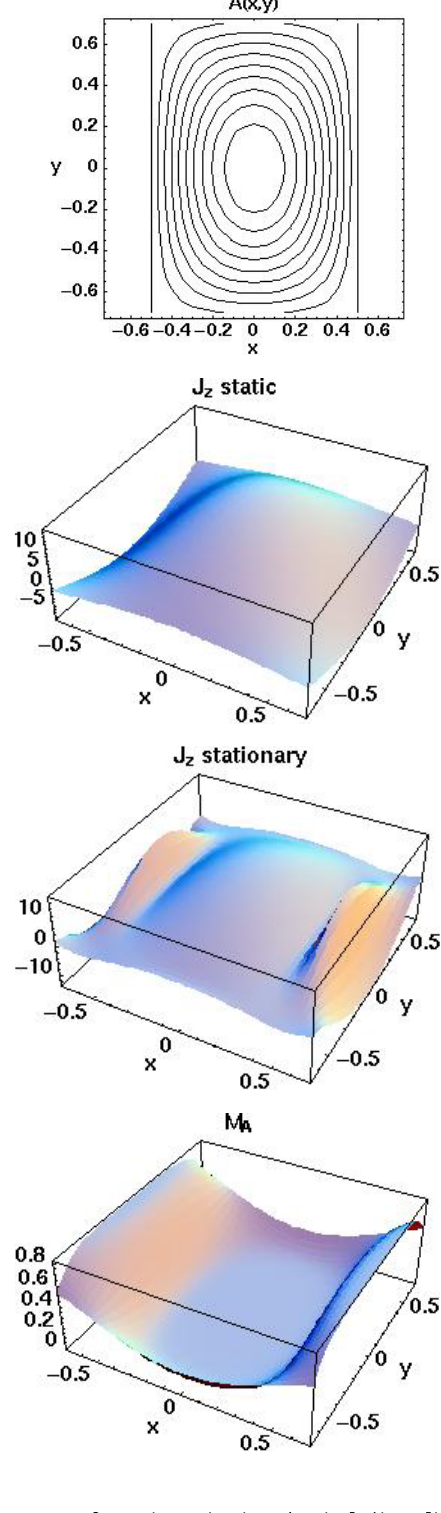
Fig. 3. Same transformation as in Fig. 2, including a linear MHS current J z (A) = c · A , c = 0 . 9. Second and third panel show the split of linear (MHS, without flow) and the full current (with flow).